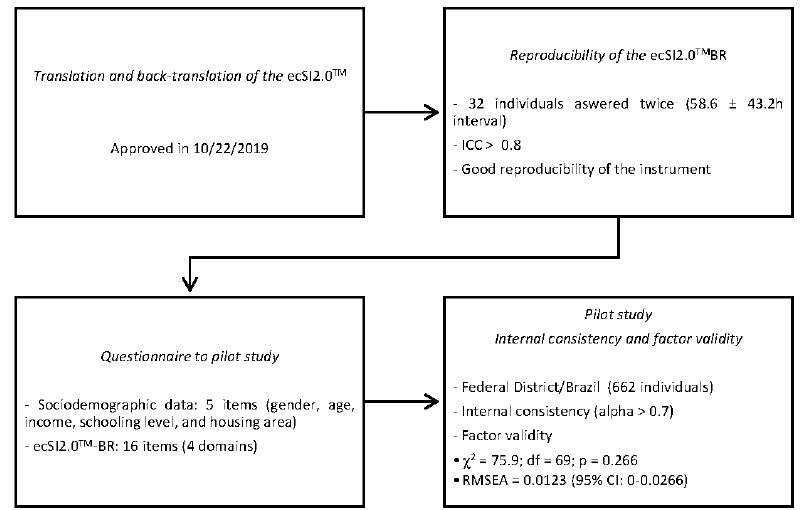
Figure 1. Flowchart of the steps to translate and validate the Satter Eating Competence Inventory in Brazilian-Portuguese (ecSI2.0 TM BR).